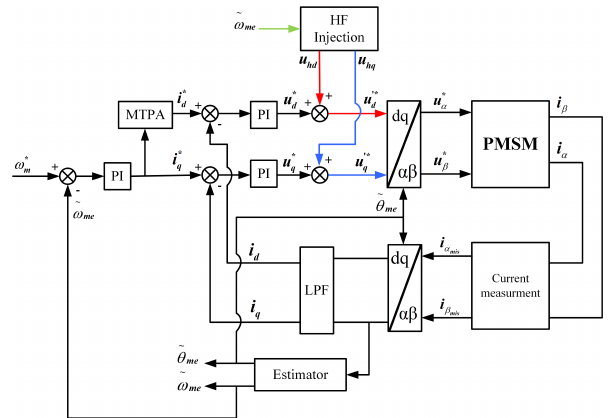
Figure 11. Sensorless control scheme with HF signal injection